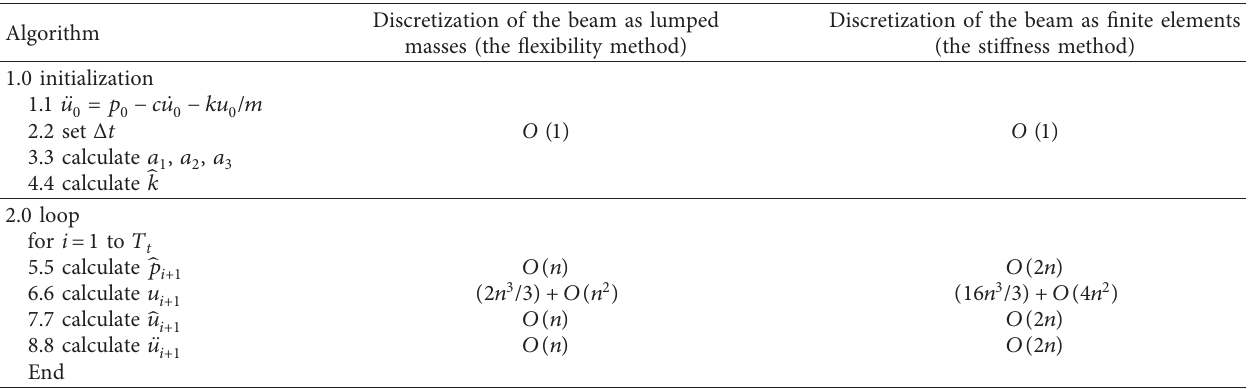
Table 2: Computational schema of Newmark’s method using (9).